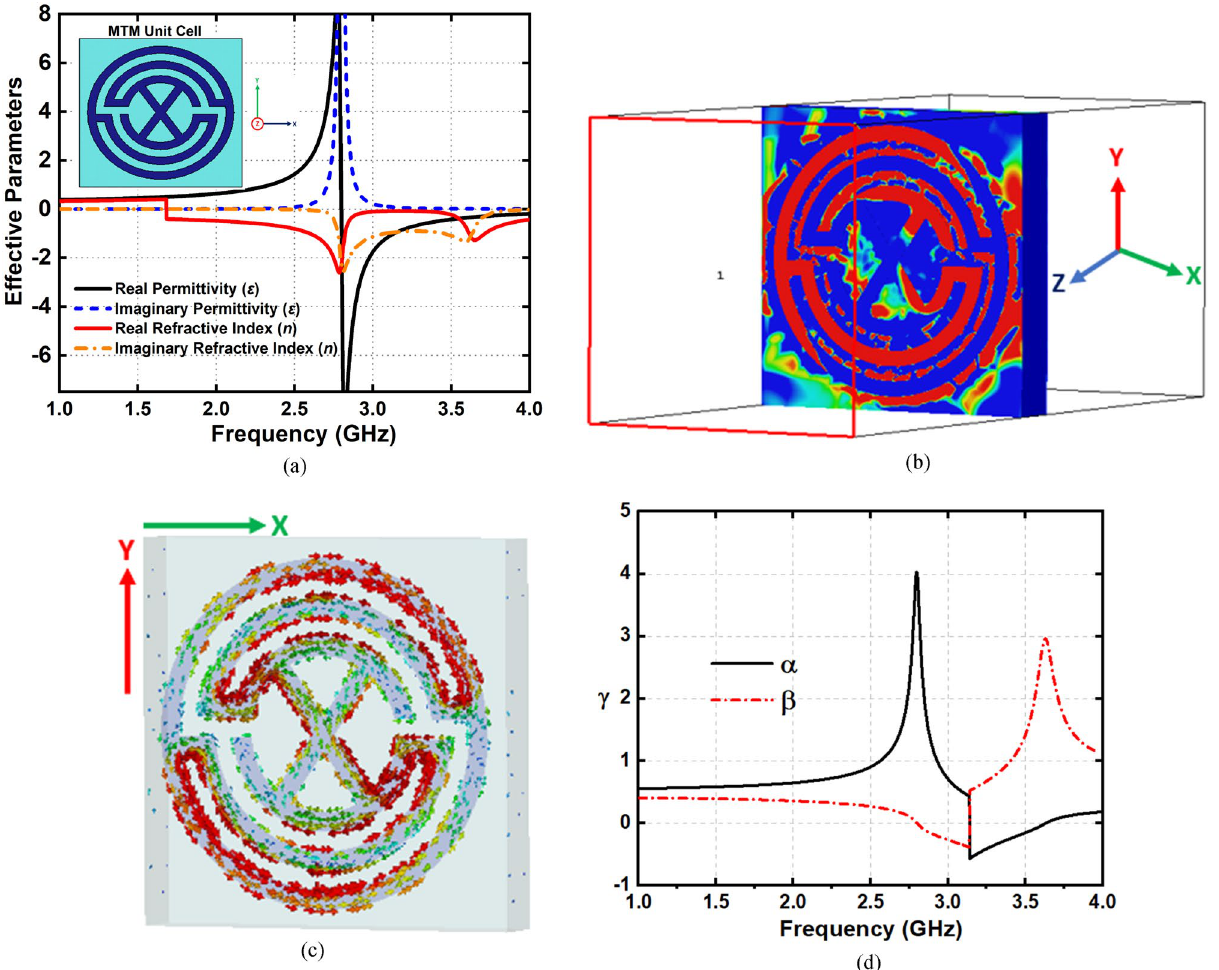
Figure 4. ( a ) Retrieved effective permittivity and refractive index of the MTM unit cell structure ( b ) Surface current at 2.8 GHz ( c ) E-field at 2.8 GHz, and ( d ) Propagation